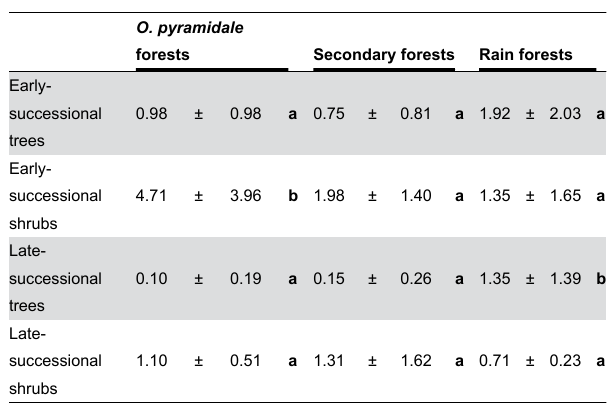
Table 3. Mean abundance (± AAD; average of absolute deviation) as the number of frugivorous bats per seed species encountered in fecal samples or carried fruits categorized per life form (tree and shrub) and successional stage (early or late).